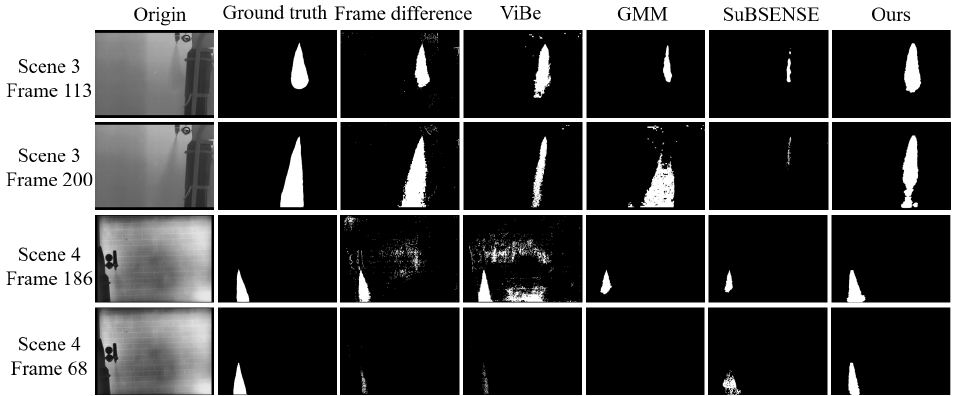
Figure 11. Comparison of detection results of different frame algorithms in the